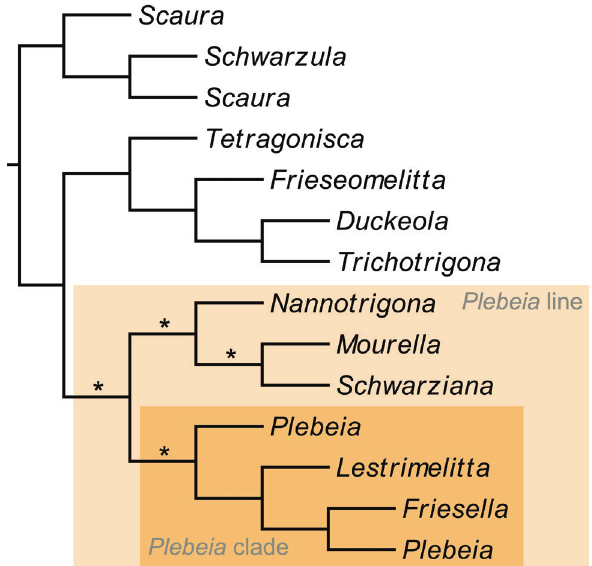
Figure 12. Summary of the phylogenetic relationships, at genus level, recovered in the study of R asmussen & C ameRon (2010) for the stingless bee taxa related to Plebeia . The color boxes highlight the Plebeia line and the Plebeia clade, two lineages discussed in the text. The putative placements predicted herein for Plectoplebeia gen. nov. are indicated by asterisks (see text for further